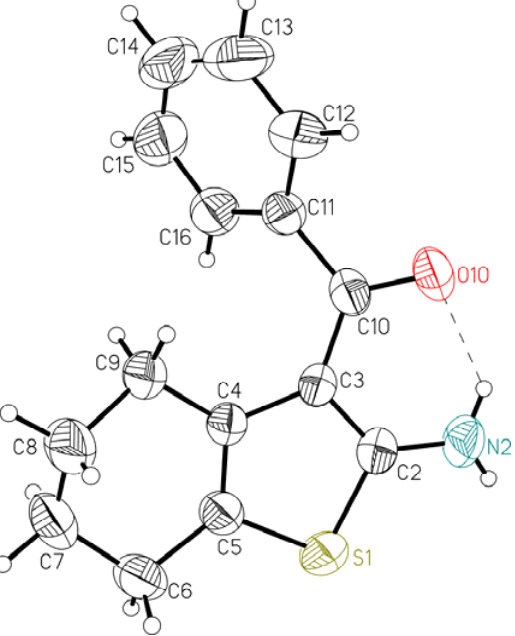
Figure 1. Ellipsoid representation of molecule 1 together with the atom labeling scheme [9]. The ellipsoids are drawn at 50% probability level, hydrogen atoms are depicted as spheres with arbitrary radii. The intramolecular hydrogen bond is drawn as a dashed line.